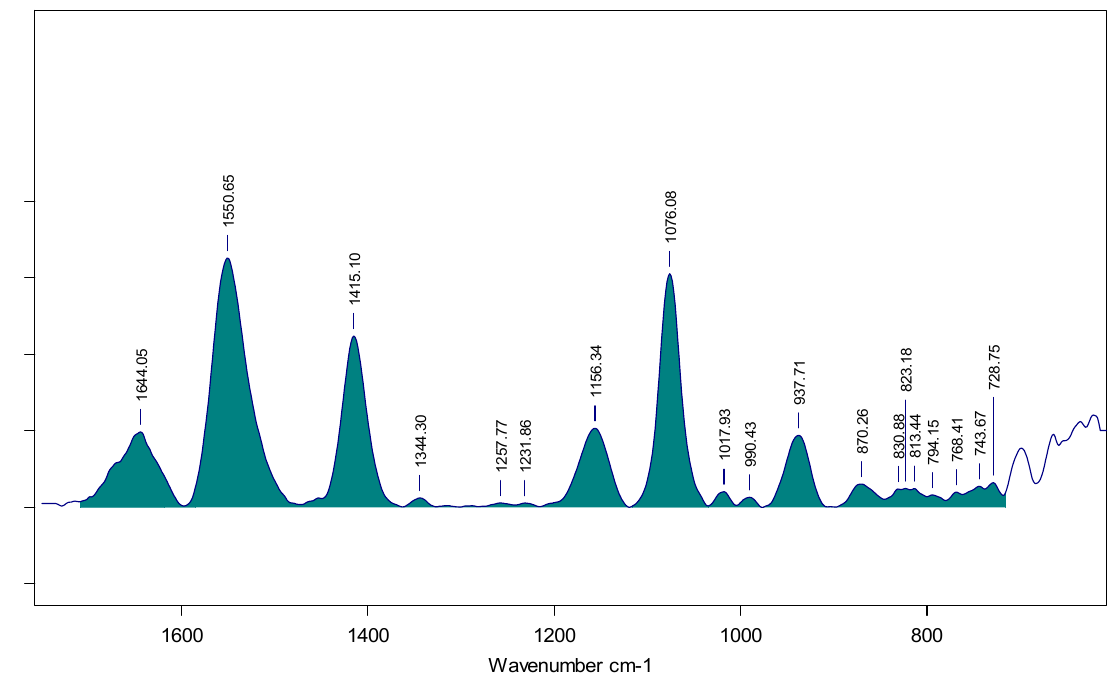
Figure 3. FTIR spectra (in the frequency range 1800–600 cm − 1 ) of a peptides-minerals complex, <3000 Da fraction (and in particular for the sample obtained by cathepsin B at the 1/20 ratio, as example). 3.1. Effect of the Enzyme, of the Ratio E/C and of the Treatment on the Antioxydant Activity